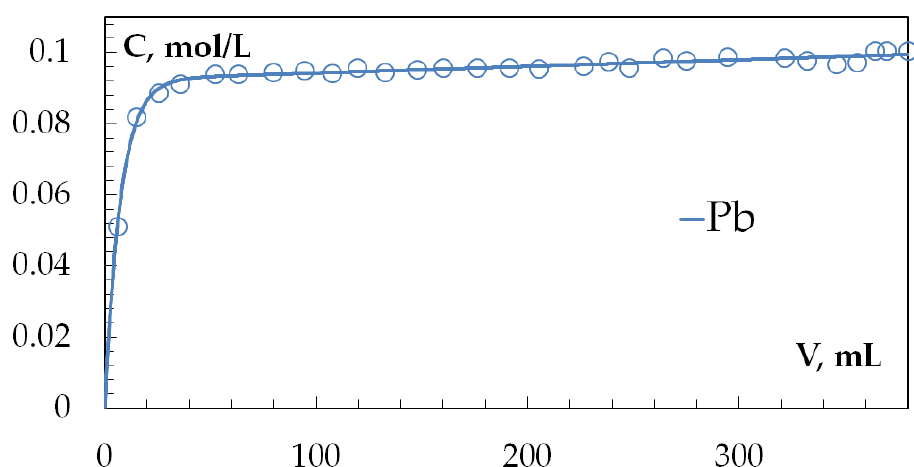
Figure 9. Results of Hg 2+ sorption by organic material.